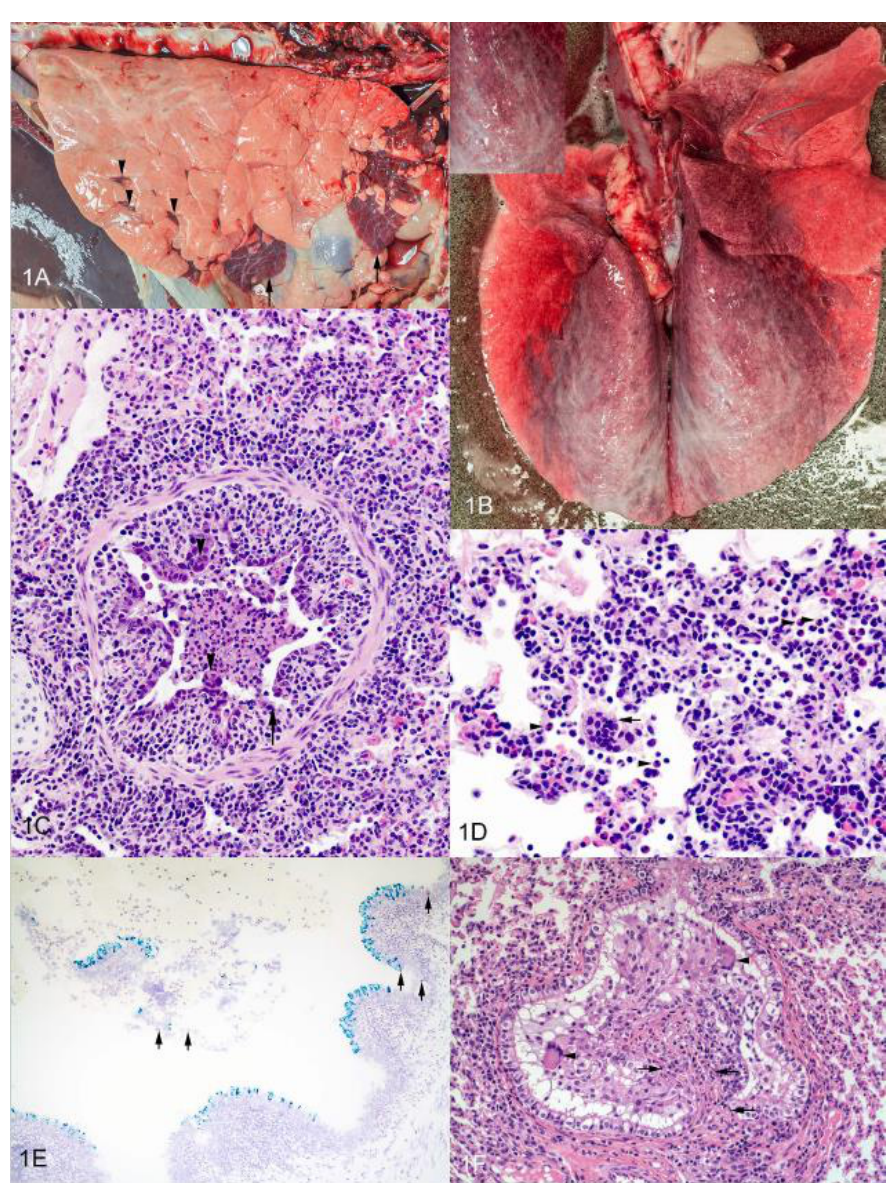
Figure 1. Gross and microscopic pathology of experimental BRSV infection. ( A ) Lung from calf experimentally infected with bRSV and examined 7 days later. Ventral areas of right cranial and right middle lung lobes are atelectic and dark red-purple (arrows). Similar small lesions are visible in the right caudal lobe (arrowheads). The remainder of the lung failed to collapse. ( B ) Lung from calf experimentally infected with bRSV and examined 7 days later. There is an overall red discoloration to the lungs. Dorsal regions of all lobes are characterized by interlobular and subpleural edema (inset). ( C ) Photomicrograph of lung from calf experimentally infected with bRSV and examined 7 days later. There is degeneration and necrosis of bronchial epithelium with sloughed cells and debris in bronchial lumen. Some areas lack epithelium (arrows). Note epithelial syncytia (arrowheads). ( D ) Photomicrograph of lung from calf experimentally infected with bRSV and examined 7 days later. Interstitial capillaries are congested and alveolar interstitium contains numerous mononuclear cells. Alveolar lumina contain macrophages, neutrophils (arrowheads) and syncytia (arrow). ( E ) Photomicrograph of lung from calf experimentally infected with bRSV and examined 7 days later. In situ hybridization using probes for bRSV F protein (green) and IL-8 (red). ( F ) Photomicrograph of lung from calf experimentally infected with bRSV and examined 14 days later. Bronchiolitis obliterans; polypoid proliferative epithelium, including syncytia (arrowheads), supported by a fibrous stalk (arrows) fills bronchiolar lumen.